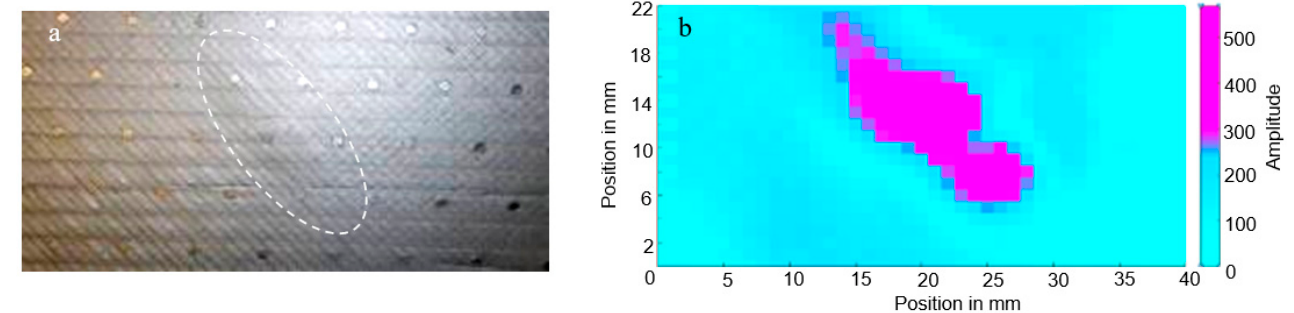
Figure 7. RACE imaging of BVID defect in CFRP plate: ( a ) photo of the defect; ( b ) AE scanning image.